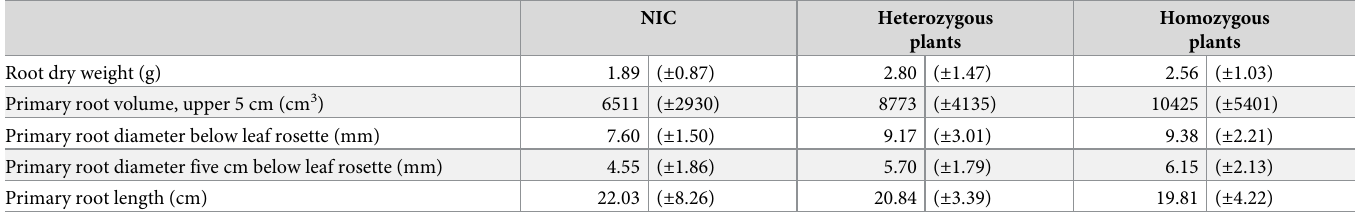
Table 2. Root characteristics of TkRALFL1 -knockout